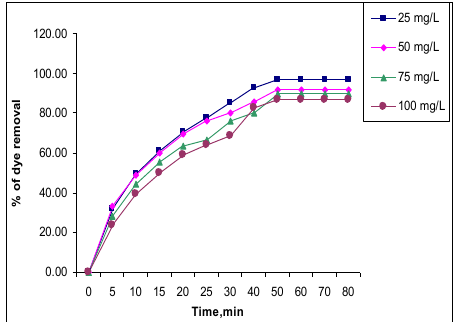
Figure 3 Effect of agitation time on the percentage removal of AV49 dye on PAC at 30° C (adsorbent dosage, 100mg; pH, 3.4).